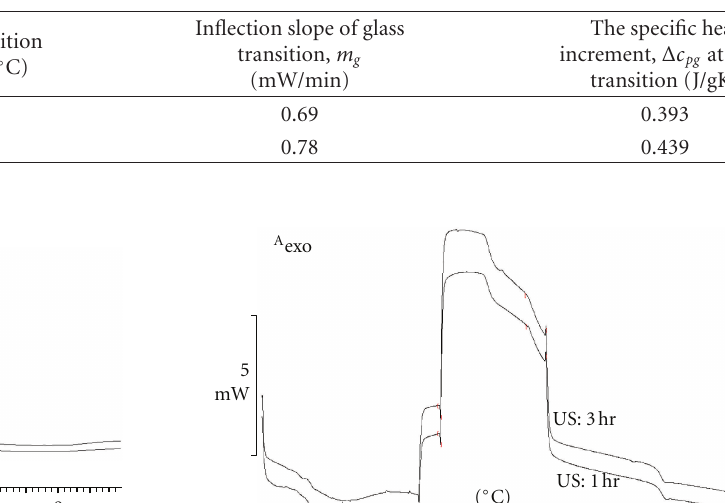
Figure 1: The TEM images of cured samples prepared by (a and b) mechanical stirring only, where aggregates of silicate can be seen [10] (c and d) 1-hour, (e and f) 3-hour ultrasonic treatment. Table 1: The analysis of glass transition temperatures during the second heating process.